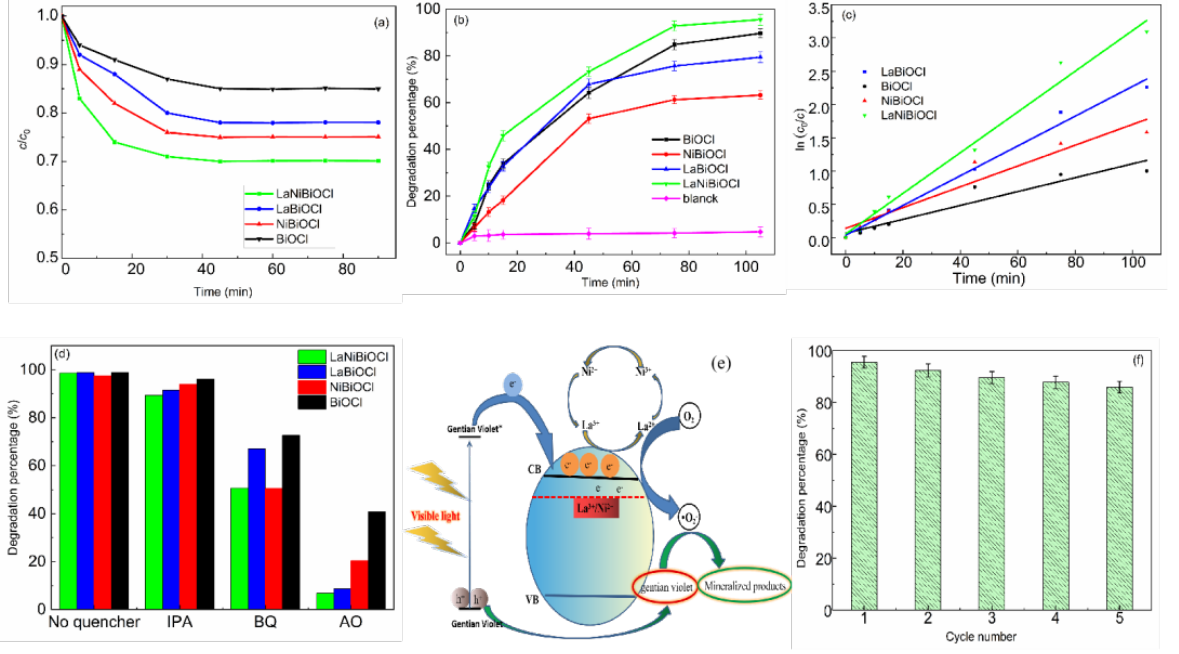
Figure 7. The dark adsorption curves ( a ), degradation curves ( b ), linear kinetics curves ( c ), and quenchers tests ( d ) of four as − prepared samples. Cycling test ( e ) and band structure model ( f ) of LaNiBiOCl.